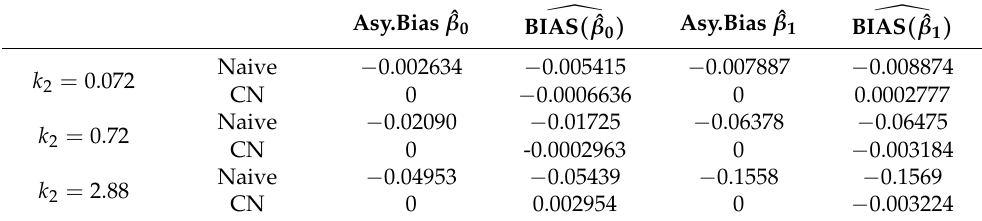
Table 3. Estimated bias of a Gamma distribution with a Gamma error.